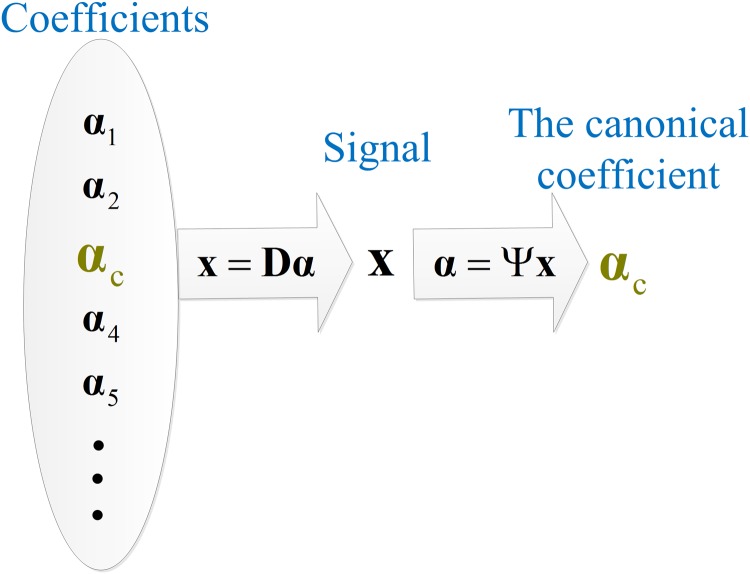
Difference between the coefficients and the canonical coefficient of a signal.